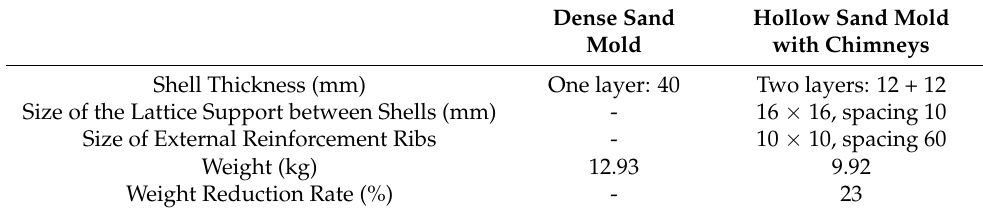
Table 2. Comparison of the traditional mold and hollow mold with chimneys.